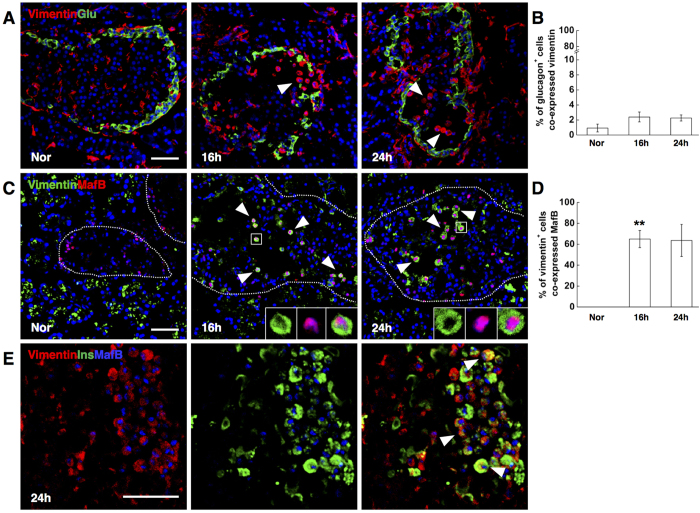
Round-shaped vimentin+ cells showed strong MafB expression.(A) Photomicrographs double stained with anti-vimentin (red) and anti-glucagon (green) antibodies. Nuclei were labeled with DAPI. Scale bars, 50 μm. The isosceles triangle: round-shaped vimentin+ cells showing negative glucagon expression. (B) Quantification of glucagon-positive cells co-expressing vimentin. (C) Photomicrographs double stained with anti-vimentin (green) and anti-MafB (red) antibodies. Nuclei were labeled with DAPI. Scale bars, 50 μm. The isosceles triangle: round-shaped vimentin+ cells coexpressing MafB. The boxed regions showed the high powered photomicrograph at the bottom right of each image. (D) Quantification of vimentin-positive cells co-expressing MafB. (E) Photomicrographs triple stained with anti-vimentin (red), anti-insulin (green) and anti-MafB (blue) antibodies. Scale bars, 50 μm. The isosceles triangle: cells co-expressing vimentin, insulin and MafB. Data are shown as means ± SEM, n = 5–6 per group. *P < 0.05 and **P < 0.01.